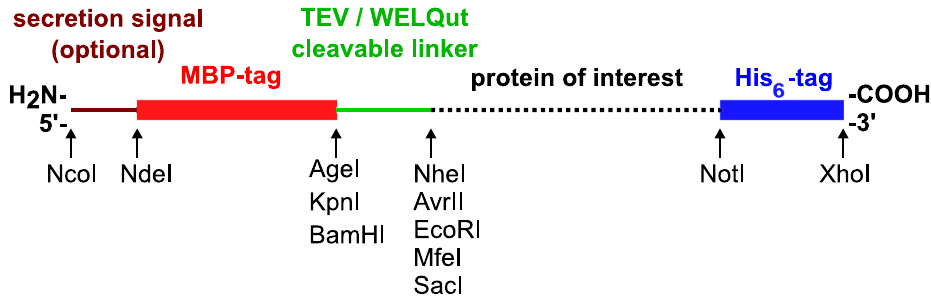
Fig 1. Features of the expression casette in the pONE vector set. The expression cassette begins with an N-terminal secretion signal, followed by a sequence of MBP affinity tag, a protease cleavable linker, the multiple cloning site, and finally a C-terminal His-tag. All of these elements are exchangeable among the vectors, provided the restriction sites are compatible. Many, but not all, restriction sites are compatible among the vectors. There is at least one appropriate restriction enzyme combination for each possible pair of vectors. Minimal requirements that make a vector “pONE” compatible : NcoI and flanking NotI and XhoI sites. At least one of AgeI/KpnI/BamHI sites at the affinity tag/cleavage tag boundary. One of the NheI/AvrII pair. One of the EcoRI/MfeI pair. The pairs generate compatible overhangs, therefore they may be ligated together. ( A ) Schematic of the multiple cloning site. ( B ) Sequence details of the intracellular MBP-TEV variant of vectors. ( C ) Sequence details of the secreted MBP-WELQ variant of